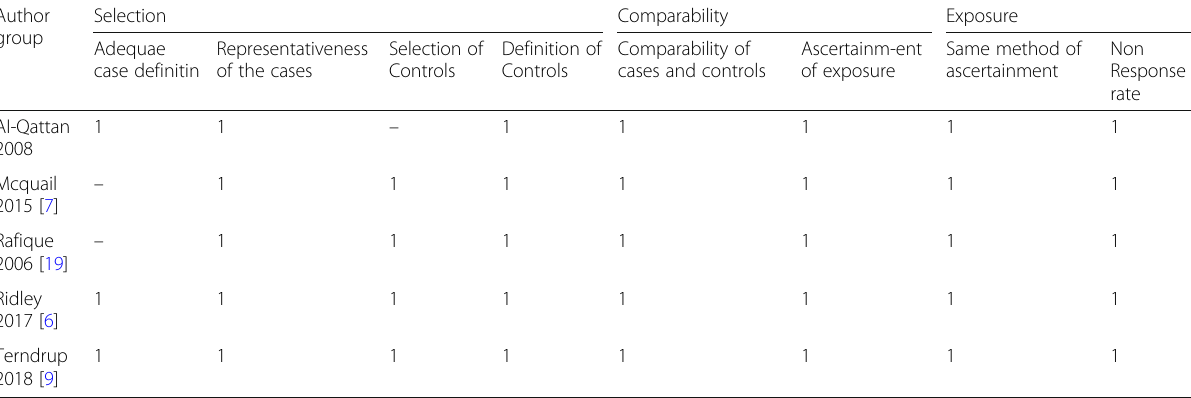
Table 3 Quality assessment of case controlled studies comparing buried versus exposed Kirschner wire osteosynthesis